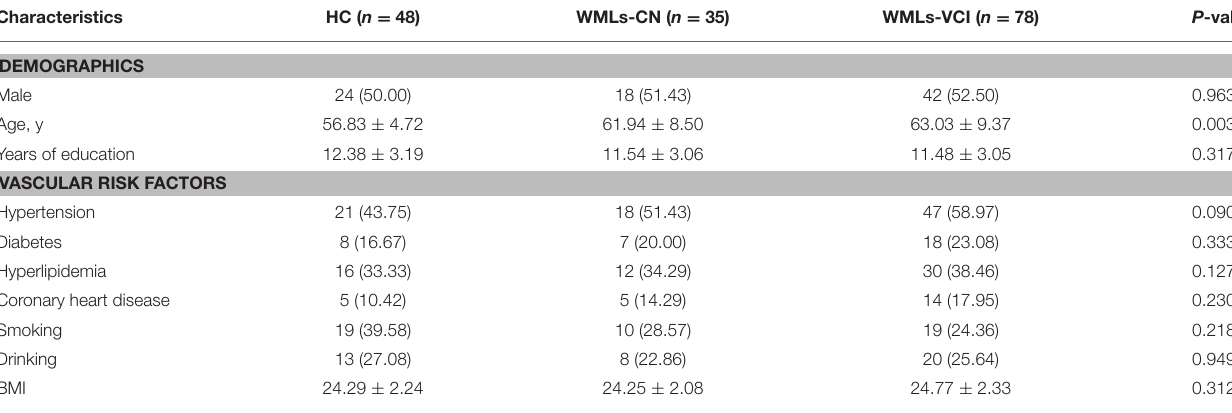
TABLE 1 | Characteristics of the study population.